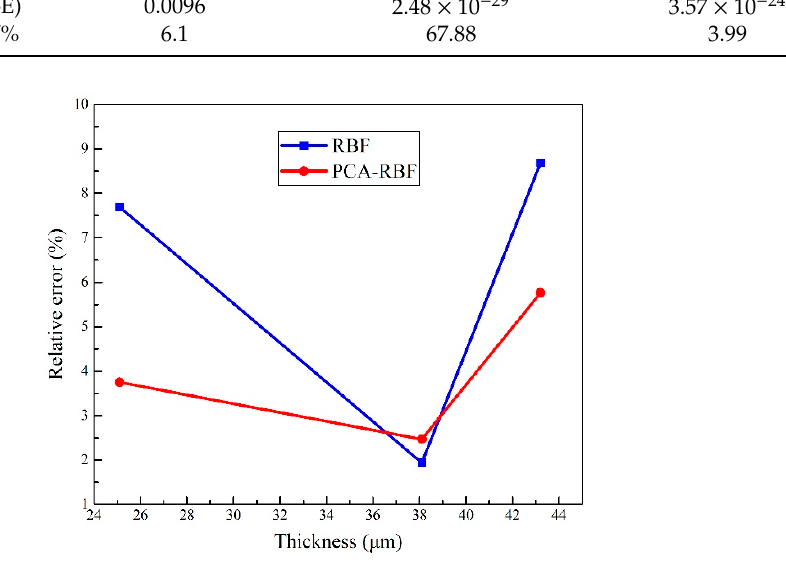
Figure 5. Relative error of the two models.